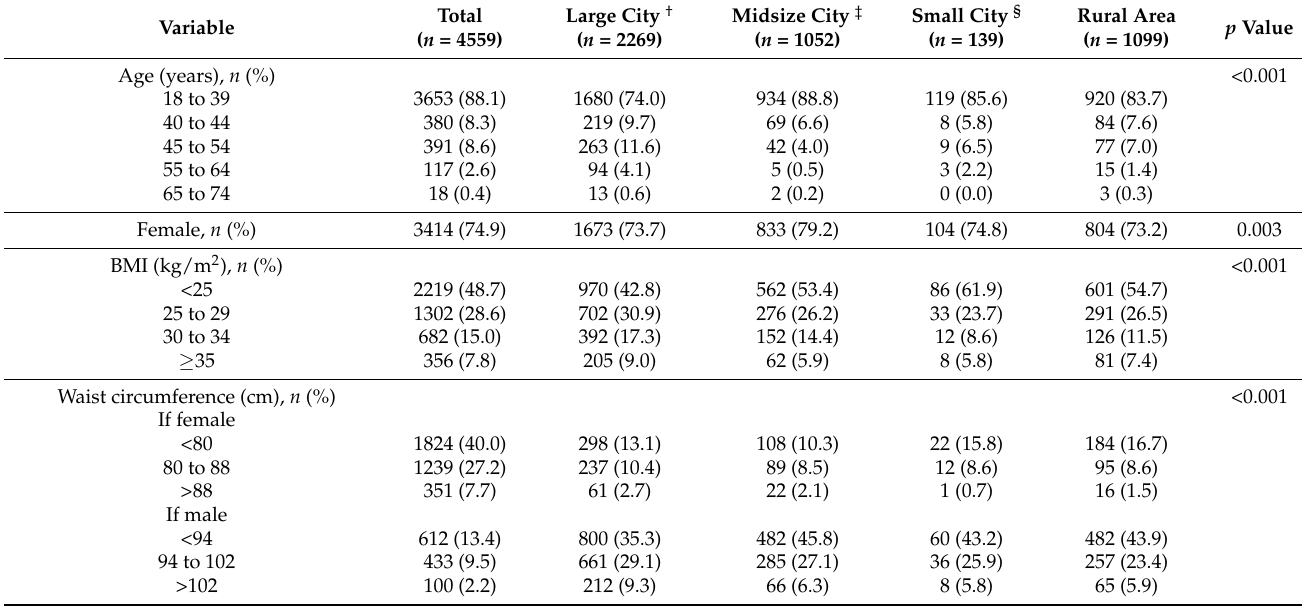
Figure 1. Flowchart of Participants. Table 1. Baseline characteristics of the surveyed sample based on city size.